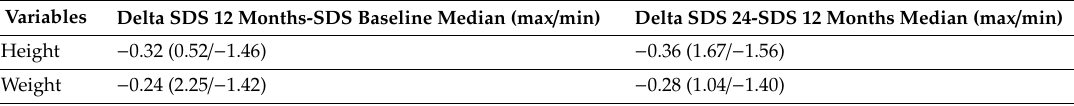
Table 2. Z-score delta changes of anthropometric measurements on patients on the ketogenic diet at 12 and 24